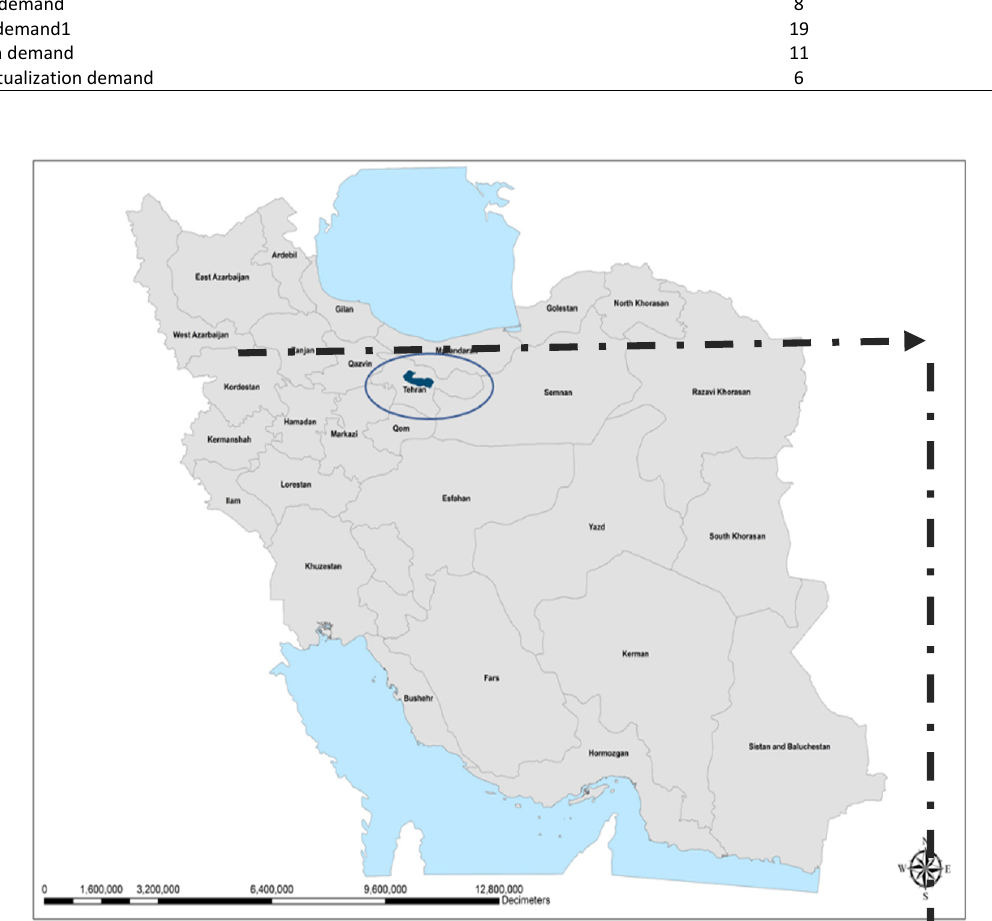
Fig. 3: Geographic location of the study area in Iran map